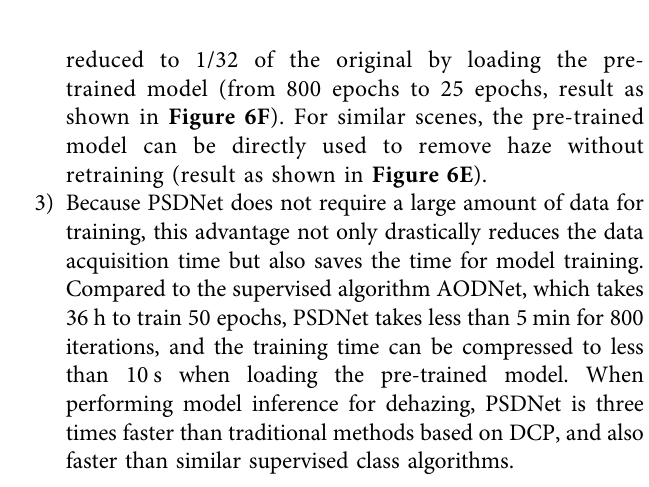
Bold value indicate the best